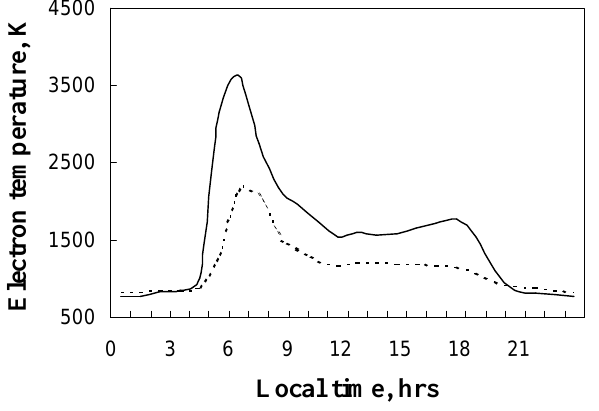
Fig. 1. Diurnal variation of observed (solid) and IRI predicted (dot- ted) electron temperature over the equator at ∼ Fig.1. Diurnal variation of observed (solid) and IRI predicted (dotted) electron temperature over equator at ~ 500km.